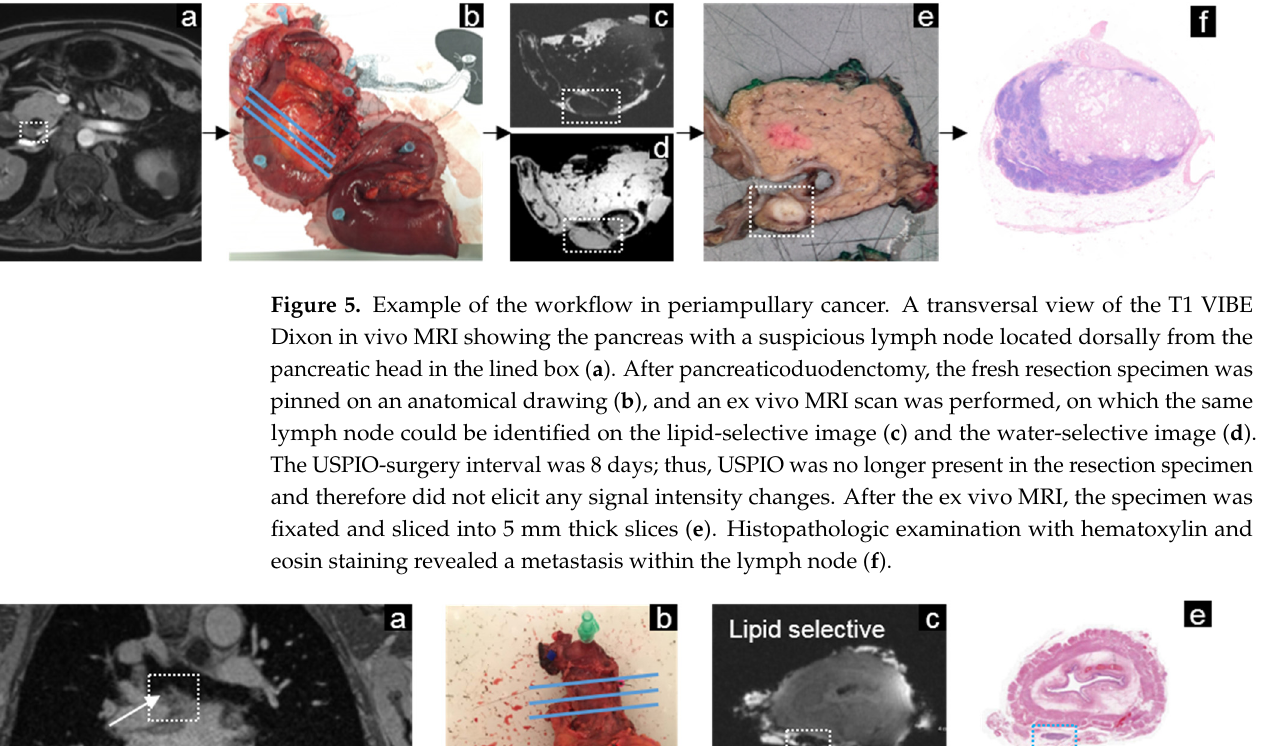
Figure 5. Example of the workflow in periampullary cancer. A transversal view of the T1 VIBE Dixon in vivo MRI showing the pancreas with a suspicious lymph node located dorsally from the pancreatic head in the lined box ( a ). After pancreaticoduodenctomy, the fresh resection specimen was pinned on an anatomical drawing ( b ), and an ex vivo MRI scan was performed, on which the same lymph node could be identified on the lipid-selective image ( c ) and the water-selective image ( d ). The USPIO-surgery interval was 8 days; thus, USPIO was no longer present in the resection specimen and therefore did not elicit any signal intensity changes. After the ex vivo MRI, the spec- imen was fixated and sliced into 5 mm thick slices ( e ). Histopathologic examination with hematox- ylin and eosin staining revealed a metastasis within the lymph node ( f ).